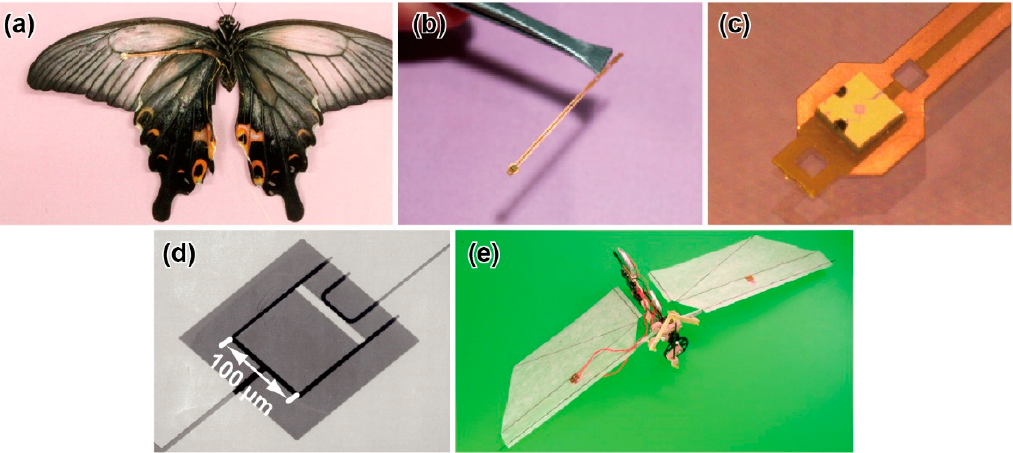
Figure 7. Photograph of a butterfly with a MEMS differential pressure sensor. ( a ) Butterfly with the sensor attached to the ventral surface of the wing. Reprinted/adapted with permission from [117]. 2022, IOP publishing. ( b , c ) Cu/polyimide flexible electrode with the sensor chip. Reprinted/adapted with permission from [117]. 2022, IOP publishing. ( d ) SEM image of the piezoresistive cantilever. Reprinted/adapted with permission from [116]. 2022, IOP publishing. ( e ) Photograph of an insect-like ornithopter with the sensor. Reprinted/adapted with permission from [118]. 2022, IOP publishing. Table 3. Characteristics of the butterfly specimen and differential pressure sensor.